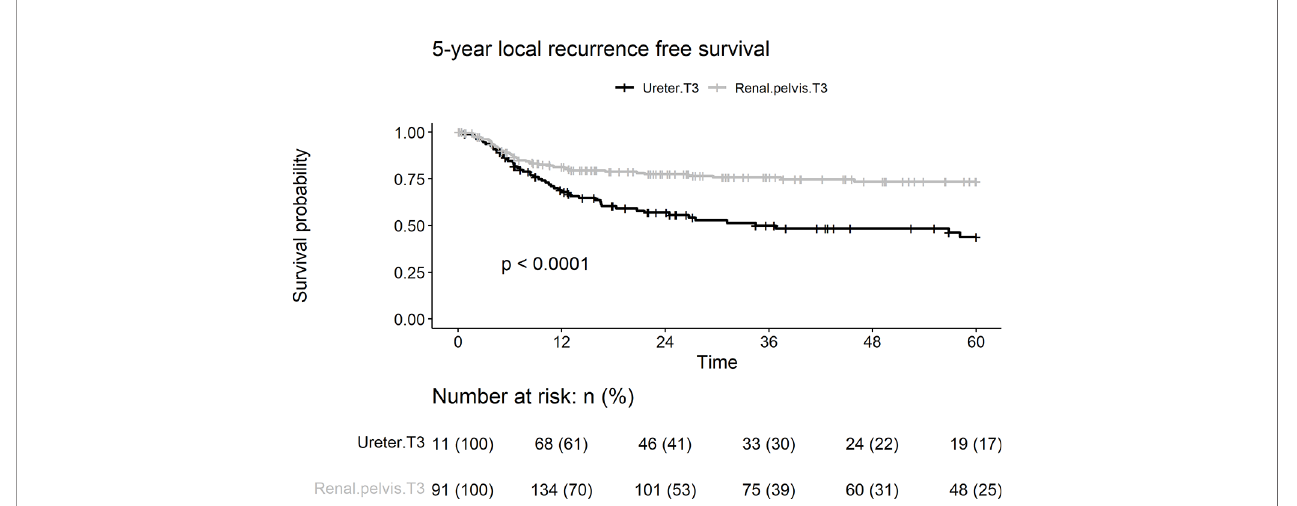
FIGURE 2 | Kaplan-Meier analyses for 5-year local recurrence-free survival strati fi ed by tumor stage among patients with pT3N0M0 upper tract urothelial carcinoma following radical